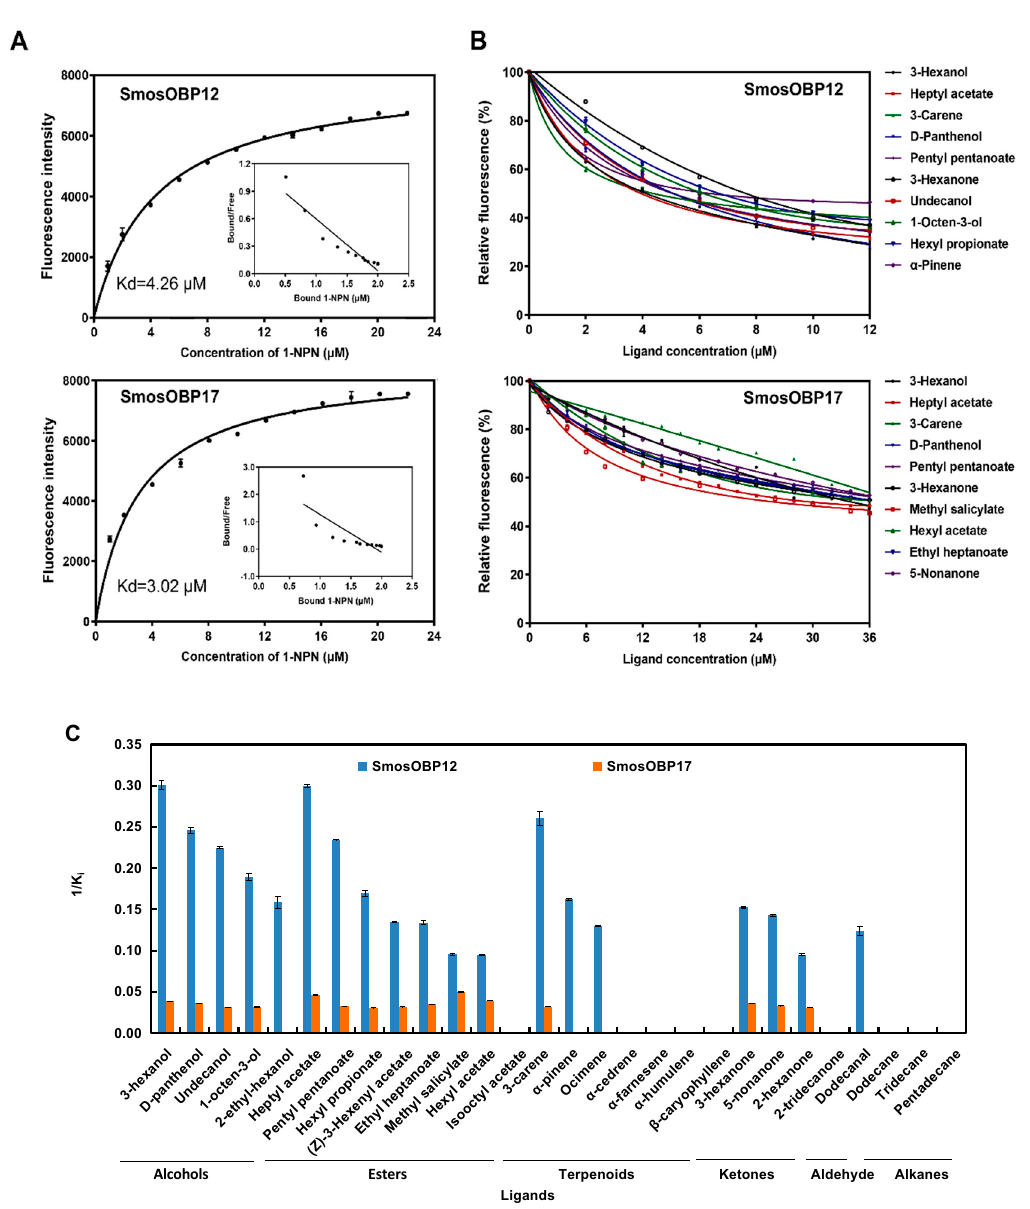
Figure 3. Ligand-binding assays of recombinant SmosOBP12 and SmosOBP17. ( A ) Binding curves and Scatchard plots of SmosOBP/1-NPN associations. ( B ) Fluorescence competitive binding curves of SmosOBPs to the 10 tightest bound ligands. ( C ) Affinities (1/K i ) of tested ligands to the two SmosOBPs. Data are means of three independent experiments. The error bars of some points may not be clearly seen because they are too small to be displayed.